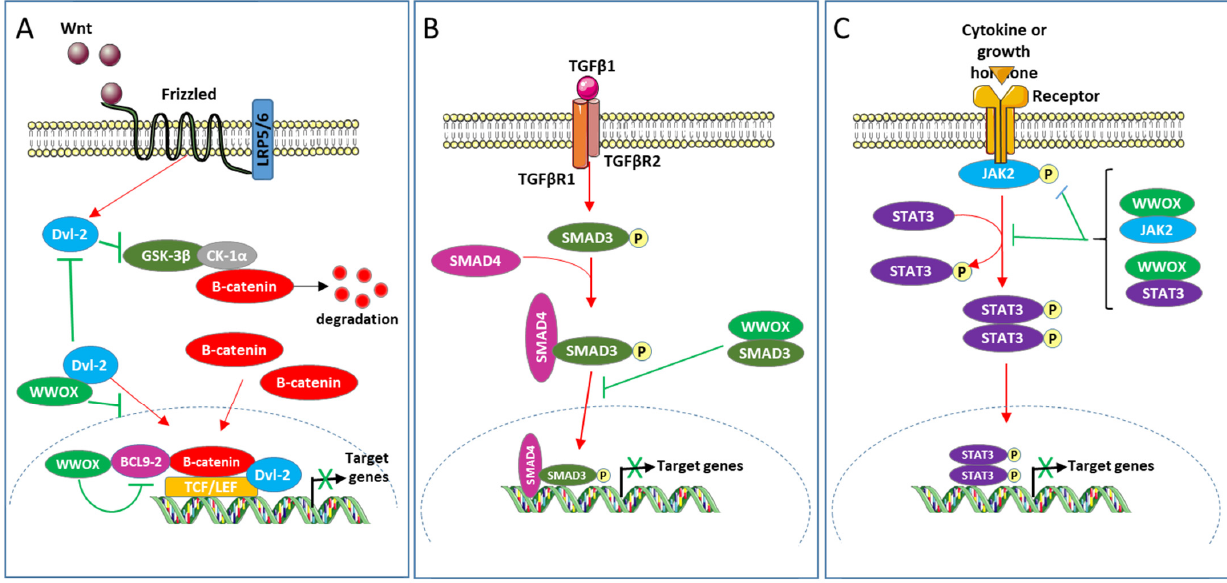
Figure 2. ( A ) Modulation of Wnt/ β -catenin, ( B ) TGF β 1 and ( C ) JAK2/STAT3 pathways by WWOX.